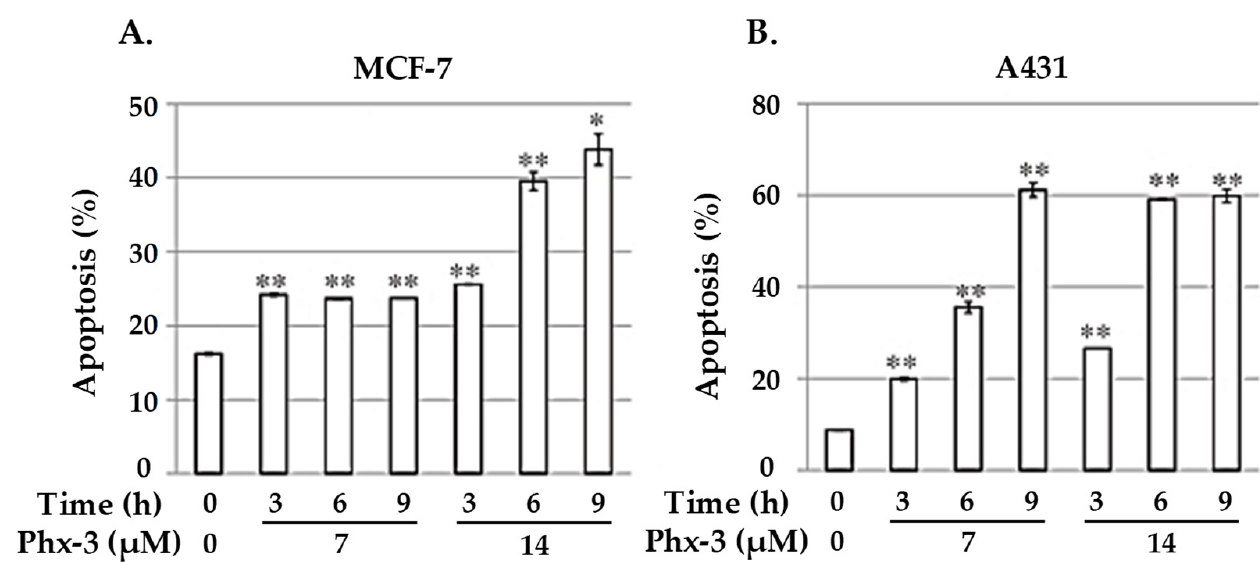
Figure 8. Proapoptotic effects of Phx-3 on ( A ) MCF-7 and ( B ) A431 cells. Reproduced from Che et al. [57] with permission of Proc. Japan Acad., Ser. B. * p < 0.01, ** p < 0.001.